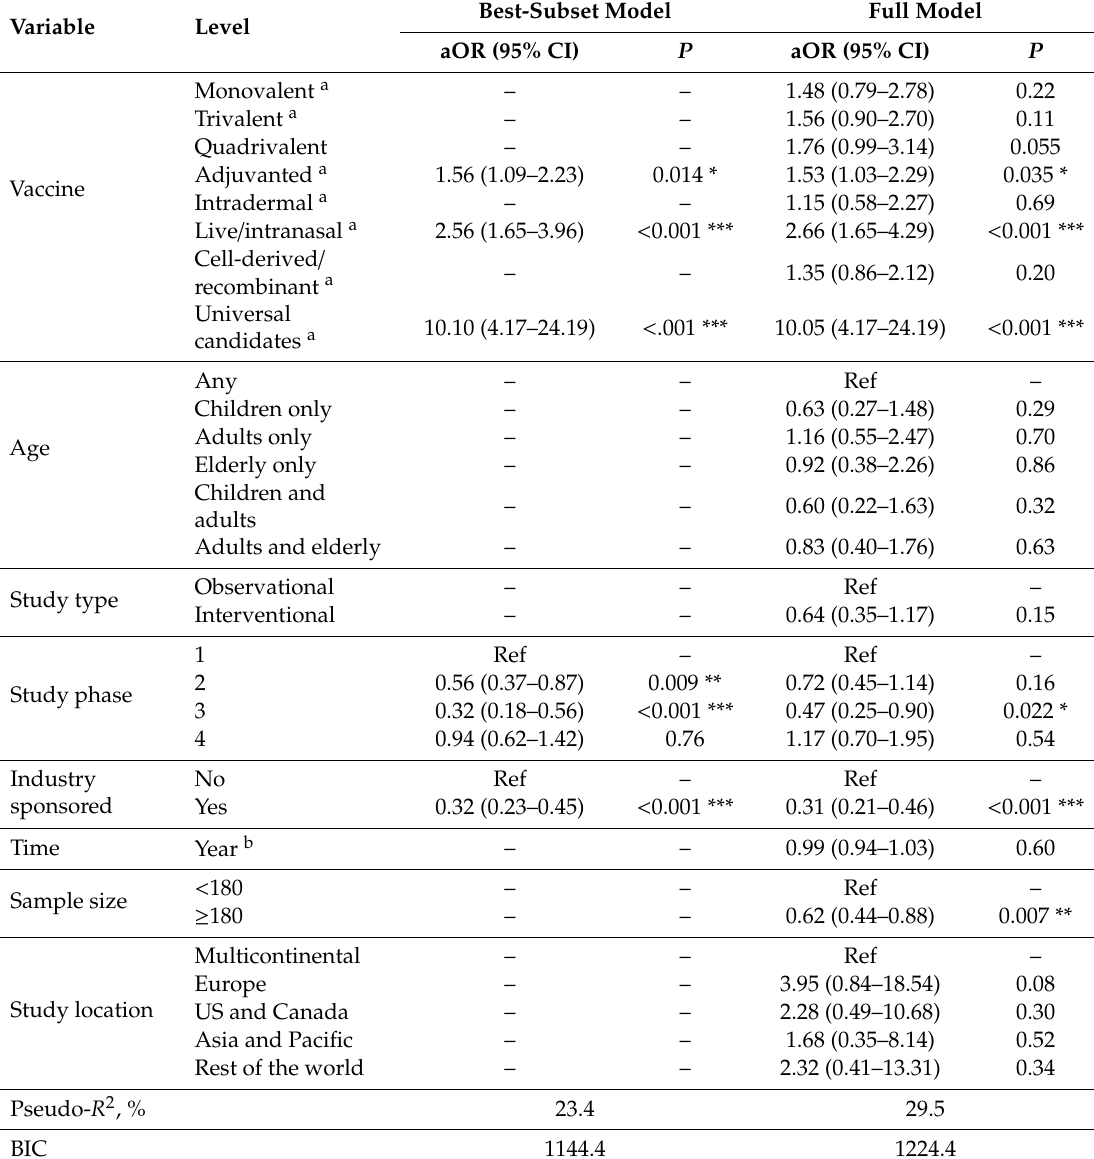
Table 4. Multivariable logistic regression models to predict the use of immunological assays measuring cell-mediated